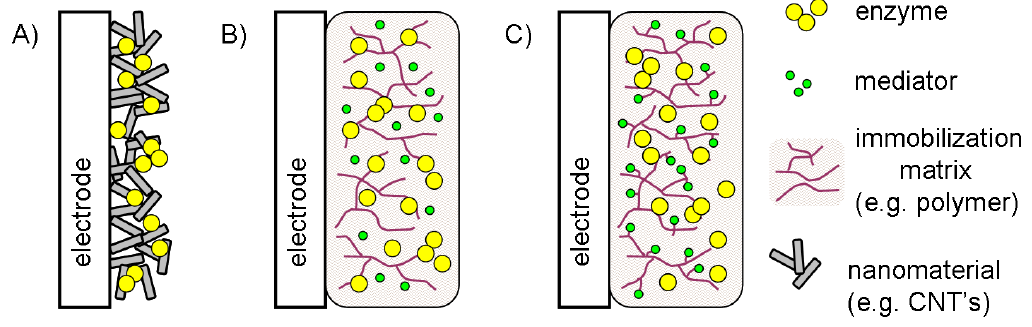
Figure 2. Schematic presentation of typical enzymatic electrode immobilization procedures. (A) Architecture based on nanostructured materials without electron transfer mediator. (B) Architecture based on enzymes and mediators entrapped in a three-dimensional